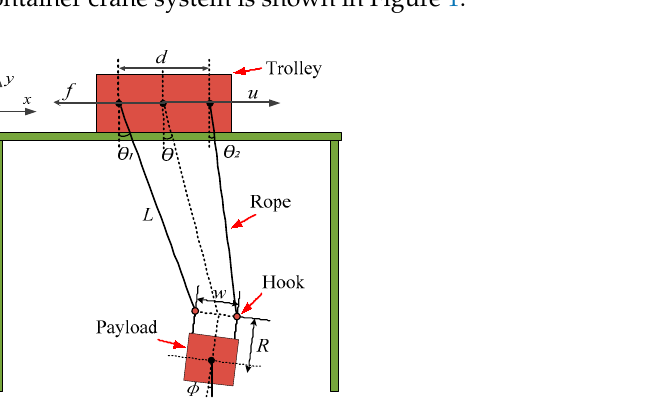
Figure 1. Two-dimensional model of crane system.